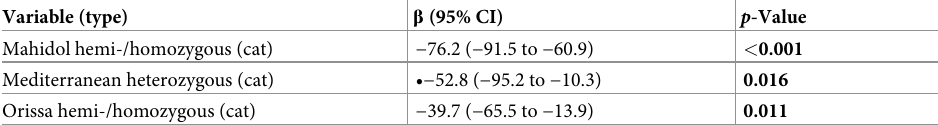
Table 8. Significant predictors of non-normalized G6PD activity among cases and controls. Variable (type) β (95% CI) p- Value Mahidol hemi-/homozygous (cat) − 76.2 ( − 91.5 to − 60.9) Mediterranean heterozygous (cat) • − 52.8 ( − 95.2 to − 10.3) 0.016 Orissa hemi-/homozygous (cat) − 39.7 ( − 65.5 to − 13.9)